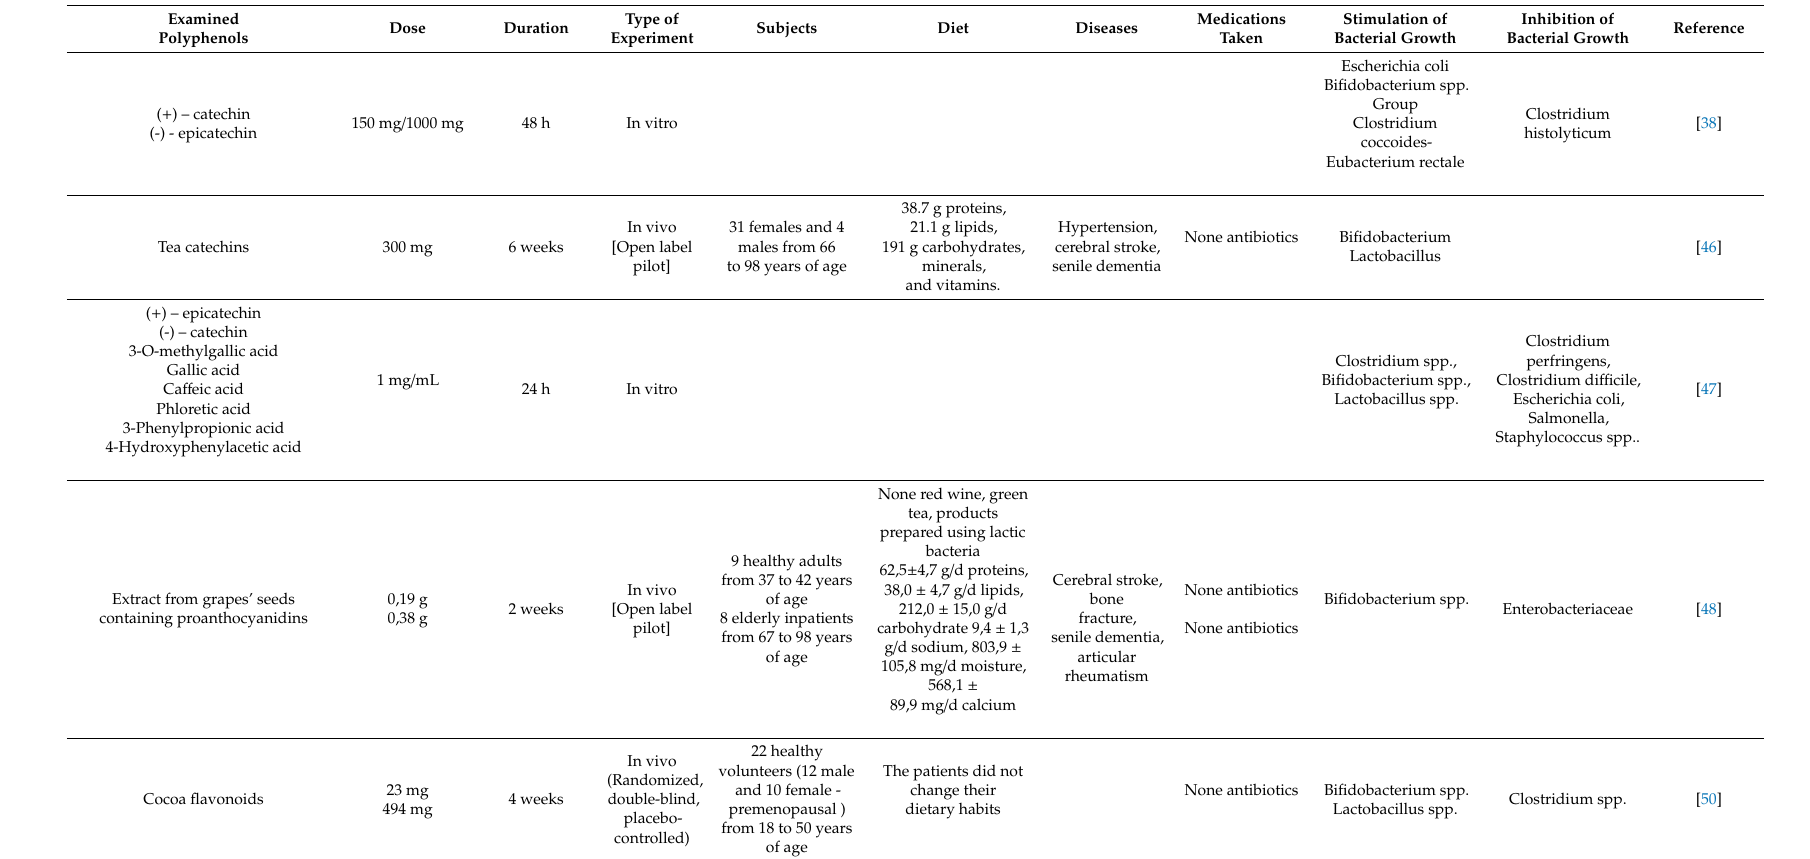
Table 2. The e ff ects of the intake of polyphenols on intestinal